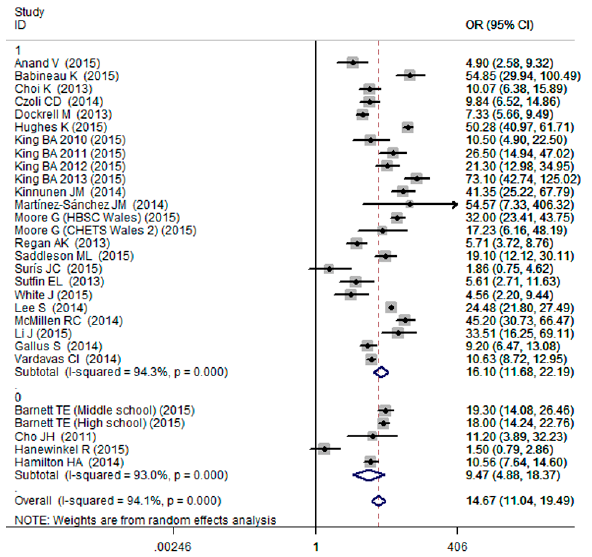
Figure 3. Effects of ever and current cigarette smoking on ever e-cigarettes use (0: ever smoking; 1: current smoking).